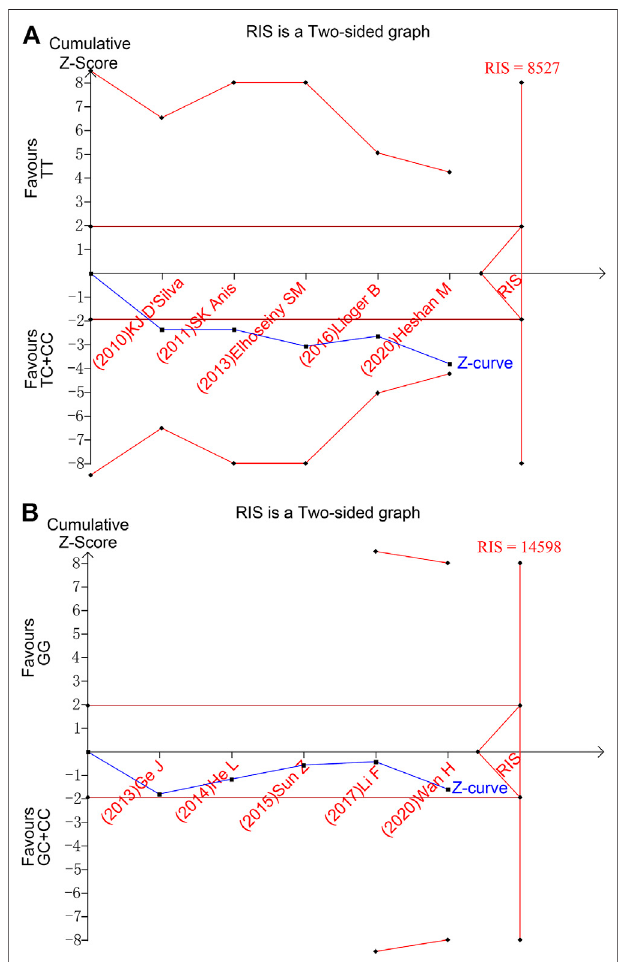
FIGURE 4 | Trial sequential analysis results of TT vs TC + CC of SNP1858 group and GG vs GC + CC of SNP1123 group. (A) TT vs TC + CC of SNP1858. (B) GG vs GC + CC of